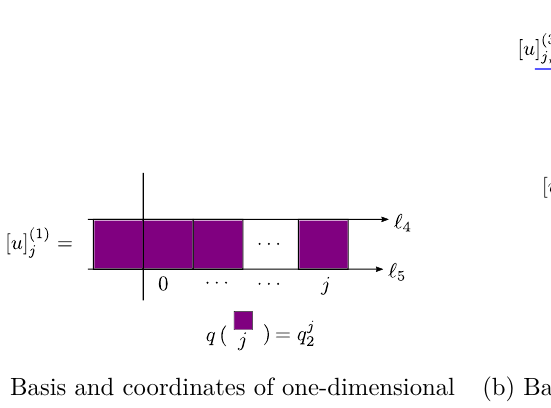
(a) Basis and coordinates of one-dimensional (b) Basis and coordinates of one-dimensional crystal representation of ‘ . The atom in crystal representation of ‘ . The atom in 4 , ‘ 5 4 , ‘ 5 the origin is in purple. the origin is chosen to be blue. Figure 48. Basis and coordinates of one-dimensional crystal representation of ‘ 4 , ‘ 5